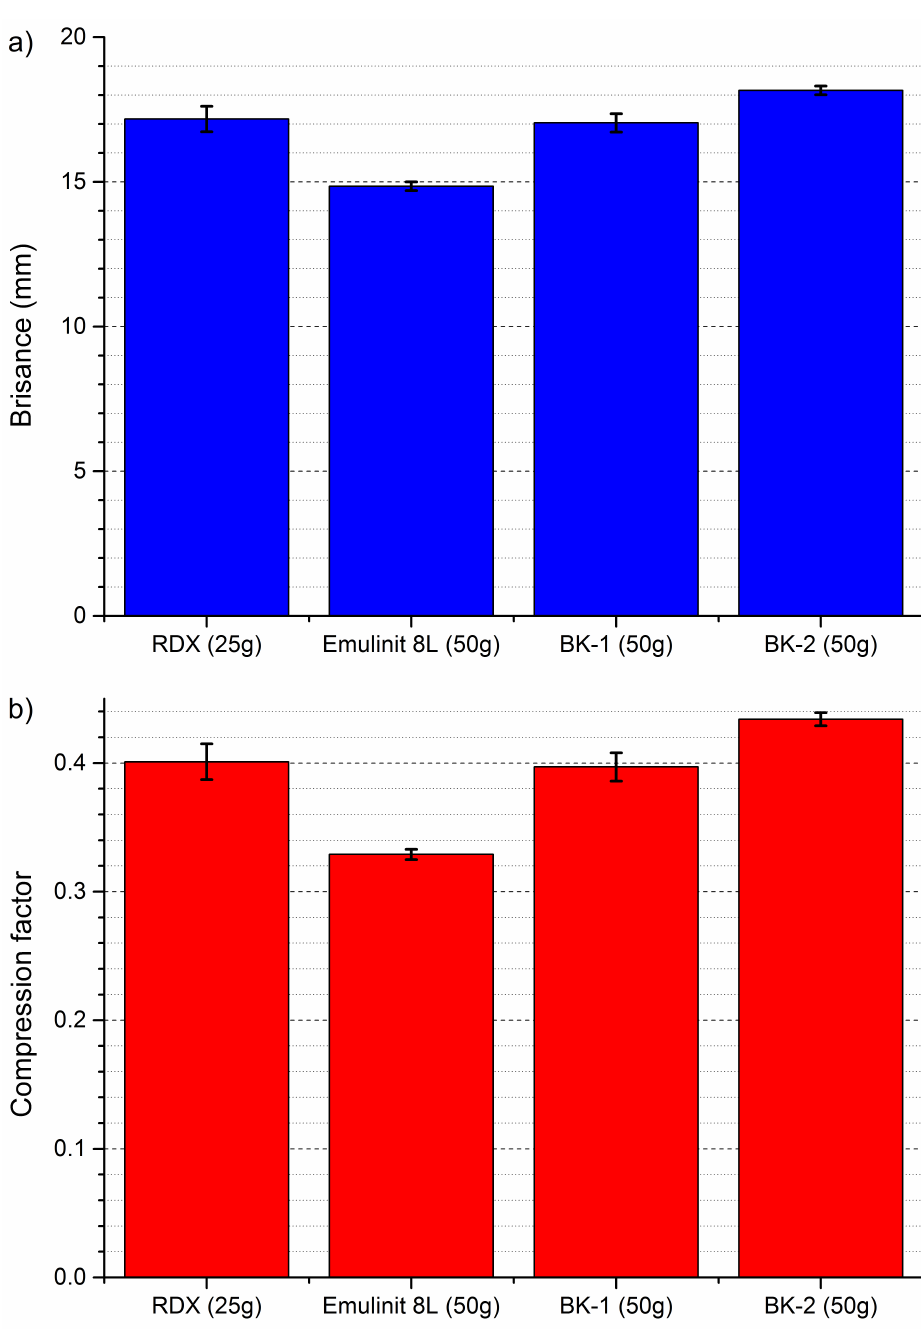
Figure 8. Comparison of ( a ) brisance and ( b ) compression factors determined for the tested EE samples and reference explosive (RDX) using the Hess